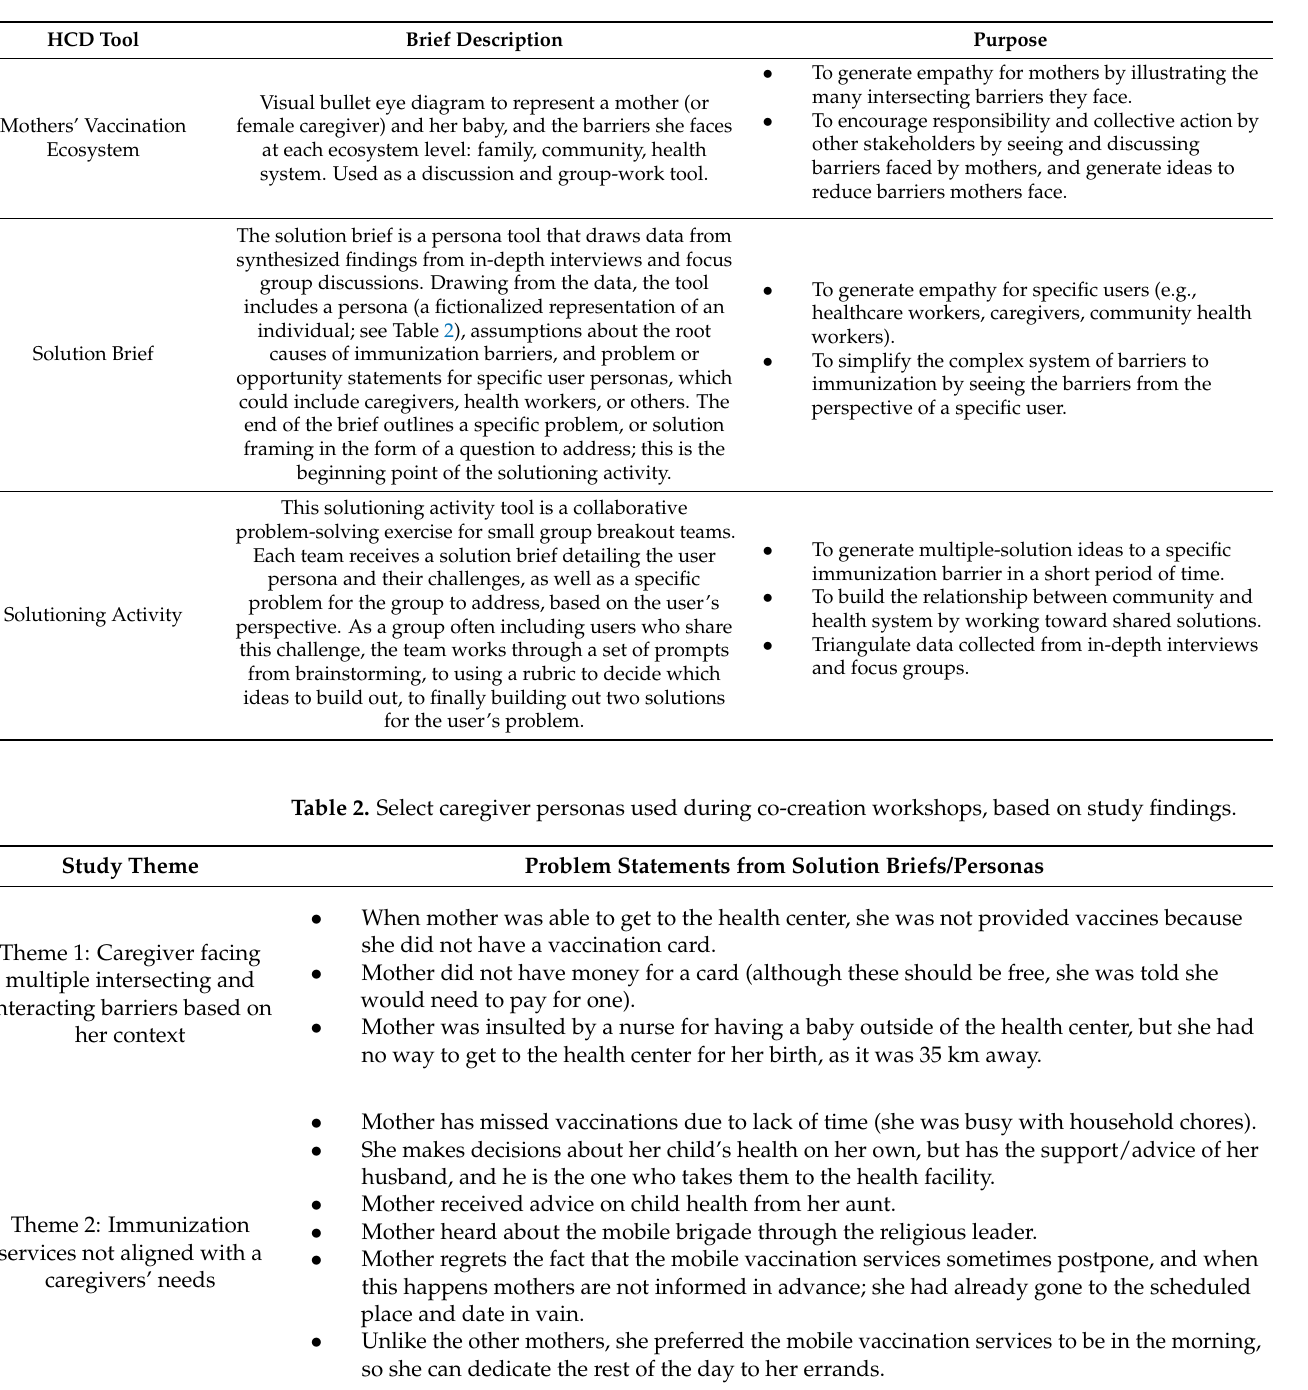
Table 1. HCD tools used during co-creation workshops.